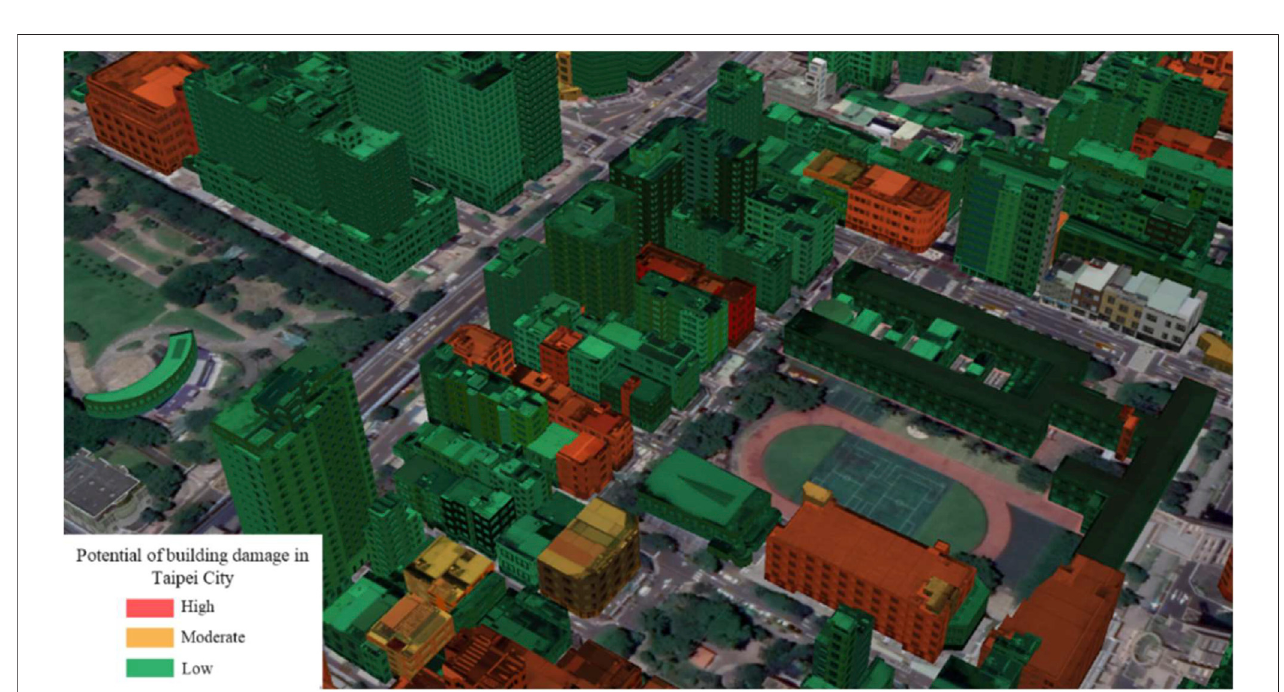
FIGURE 17 | Thematic map of the damage risk for buildings in Taipei